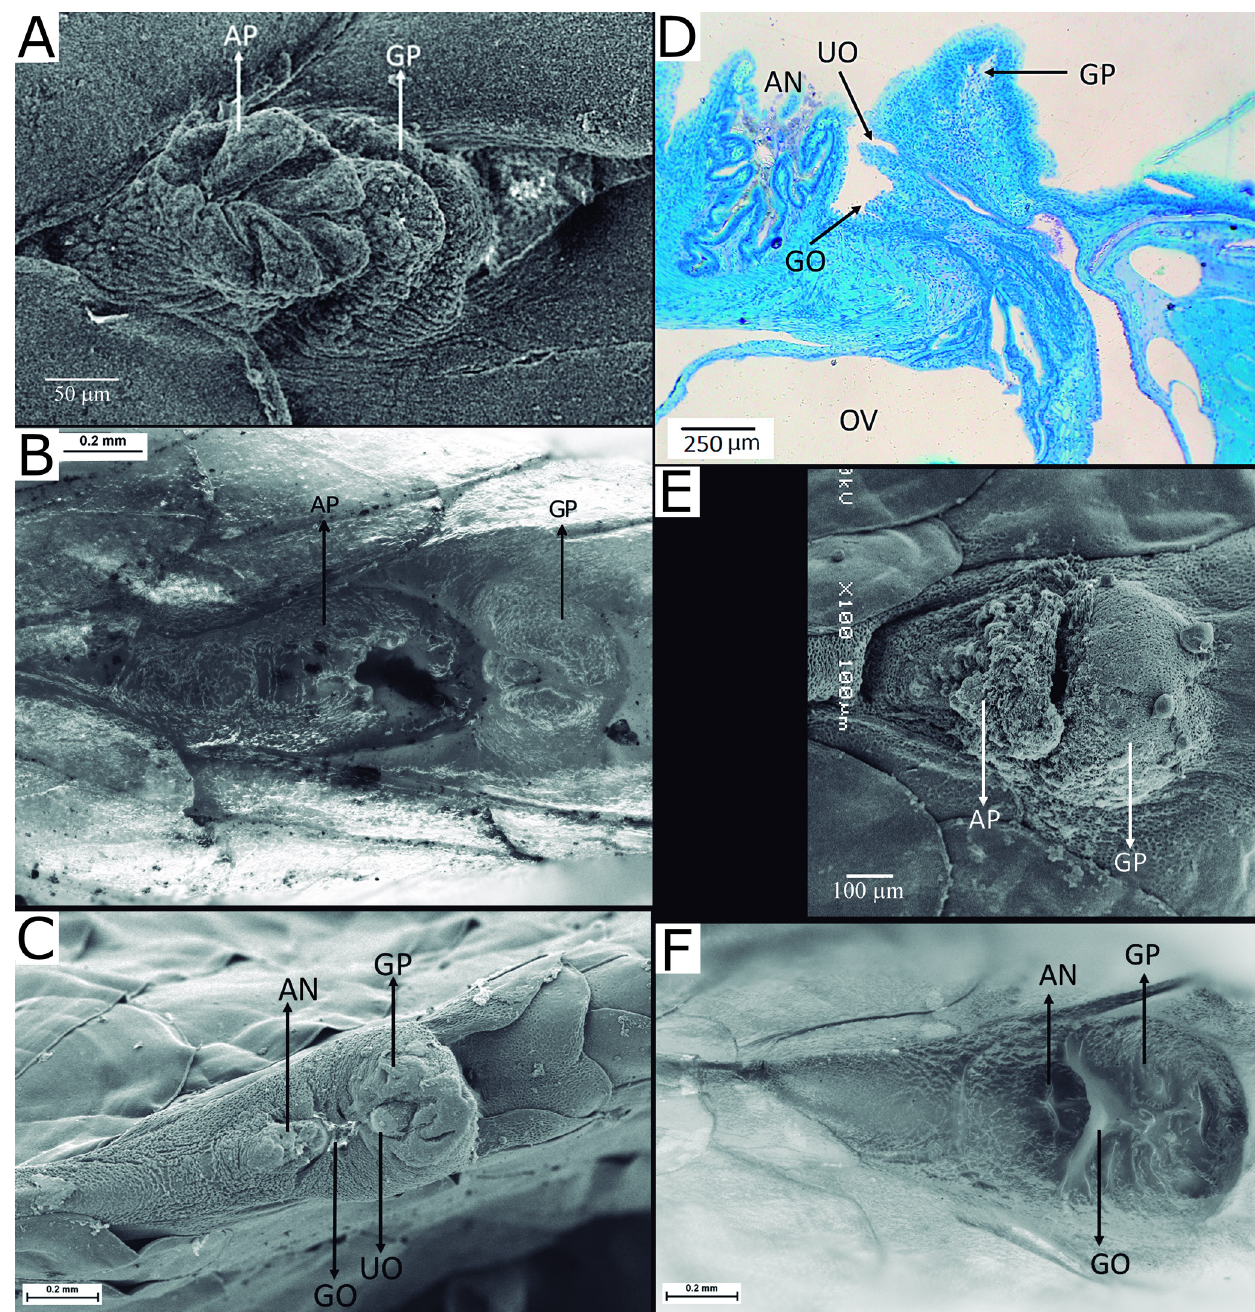
FIGURE 3 | SEM photomicrographs ( A , C , E ) and photos under stereomicroscope ( B , F ) of the genital and anal papillae in ventral view (anterior to left), and ( D ) histology of the genital and anal papillae of Compsura heterura females. A . Juvenile female measuring 17.6 mm SL. B . Virgin adult female measuring 26.56 mm SL showing the hood-like genital papilla and anal papilla. C . Genital papilla of a specimen measuring 26.56 mm SL, in ventral view, showing the separation between the genital and urinary openings. D . Genital papilla of a specimen measuring 27.24 mm SL showing the separation between the genital and urinary openings. E . Genital papilla of a specimen measuring 27.02 mm SL euthanized immediately after copulation showing the anal and genital papilla close to each other, forming a closed cavity covering the genital opening. F . Genital papilla of a specimen measuring 26.87 mm SL euthanized during spawning. AN = anus; AP = anal papilla; GO = genital opening; GP = genital papilla; OV = ovary; UD = urinary duct; UO = urinary